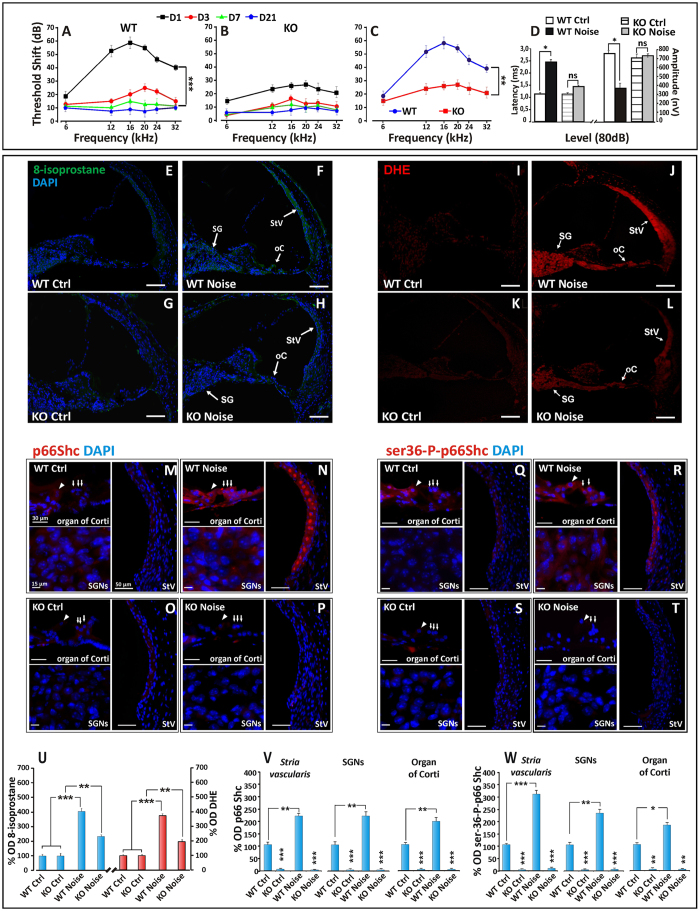
NIHL and oxidative stress are ameliorated in p66shc deficient mice.(A,B) ABR averaged threshold shift values (±SEM,) in WT Noise (n = 6) and p66KO Noise (n = 6) groups. (C) Overlay of WT Noise and p66KO Noise curves at day 1, displaying significant protection (about 40 dB TS) from early NIHL in the latter mouse strain. (D) Latency and amplitude of P1 wave at day 1 post-noise as in Fig 1C. (E–L) representative confocal images of mouse (6 μm) cochlear cryosections at day 1 post-noise exposure showing enhanced 8-isoprostane (F–H) and DHE (J–L) fluorescent signal in multiple cochlear structures (arrows) including oC, SG and StV. Fluorescence accumulation in the WT mouse indicates increased lipid-peroxidation and super-oxide production (arrows) after noise exposure (compare: E–I with F–J). Trauma-induced oxidative stress is nearly abolished in the cochleae of p66KO mice (compare: G–K with H–L). Pictures are representative of two/three sections from each of 5 animals/group (right cochleae used for 8-isoprostane and left ones for DHE staining). (M–T) Confocal representative images of cochlear cryosections immune-stained for p66shc (four panels M-P on the left) and ser36-P-p66shc (four panels Q–T on the right); (M,O,Q,S) control specimens; (N,P,R,T) day 1 after acoustic trauma. Immunostaining for both p66shc and its ser36-phosphorylated form is increased by noise in all cochlear structures of WT mice, including StV (panels N and R). No signal is detected in the corresponding cochlear structures from p66KO mice, confirming staining specificity (P,T). Arrows: OHC; Arrowheads: IHC. (U) quantification of fluorescence signal for 8-isoprostane (blue column) and DHE (red column) measured by optical density (data are normalized to control). (V,W) fluorescence signal quantitation for p66shc and ser36-P-p66shc respectively. Pictures representative of two-three sections from each of 5 animals/group (right cochleae: p66shc; left cochleae: ser36-P-p66shc). Statistics: A-D by two-way ANOVA with Tukey’s post-hoc analysis (*p < 0.05; **p < 0.001;***p < 0.0001). (U–W) by two-way ANOVA (*p < 0.05; **p < 0.001; ***p < 0.0001). Scale Bars: (E–L) 100 μm; (M–T) organ of Corti 30 μm, StV 50 μm, SGNs 15 μm.